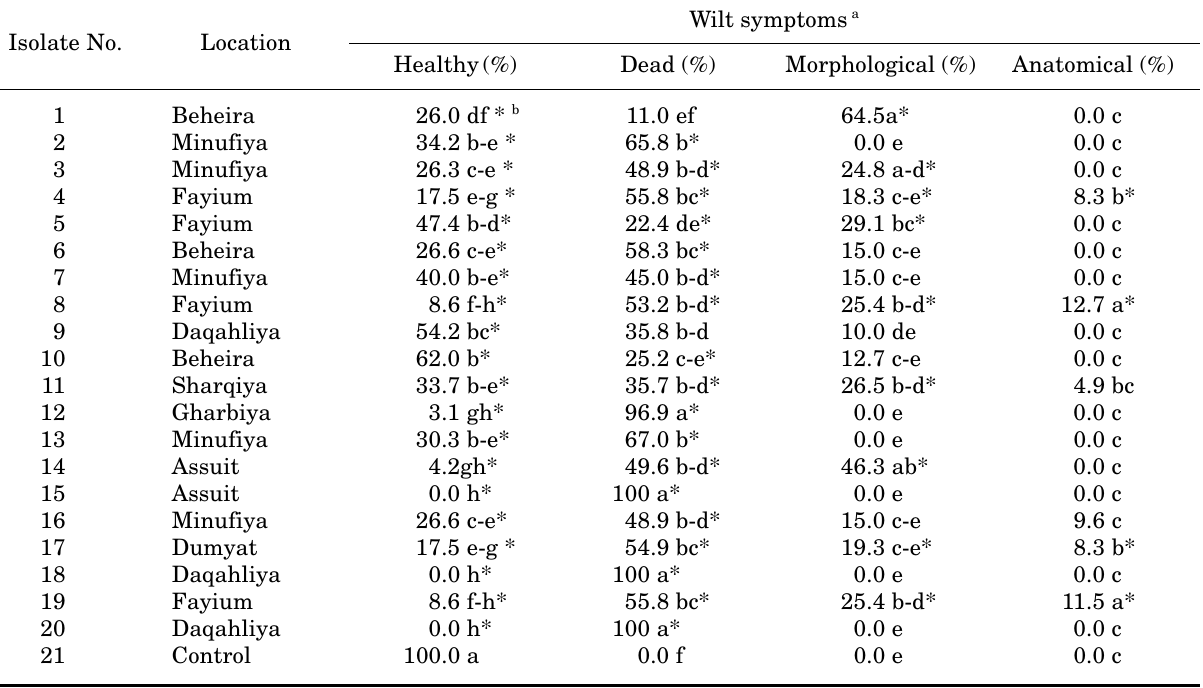
Table 1. Geographic origin of the 20 Fusarium oxysporum f. sp vasinfectum isolates and pathogenicity tests deter- mined in this study.